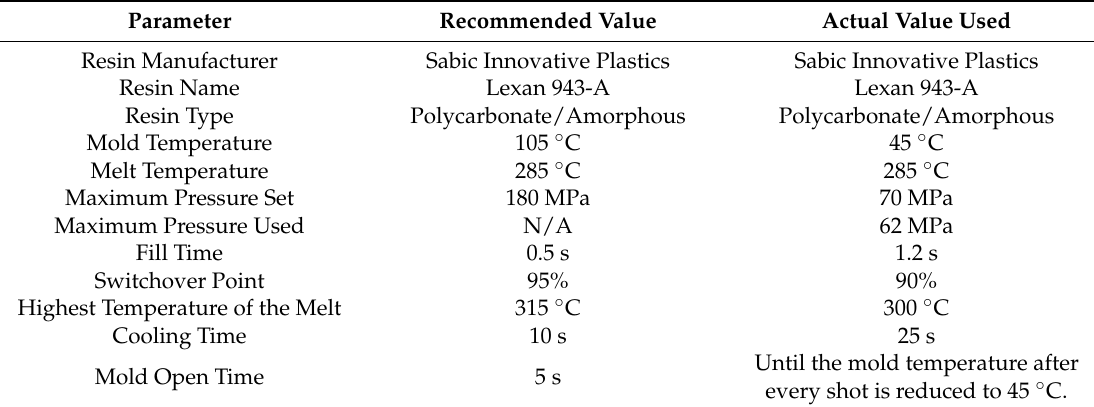
Table 4. Process parameters recommended vs used, for case study 3.